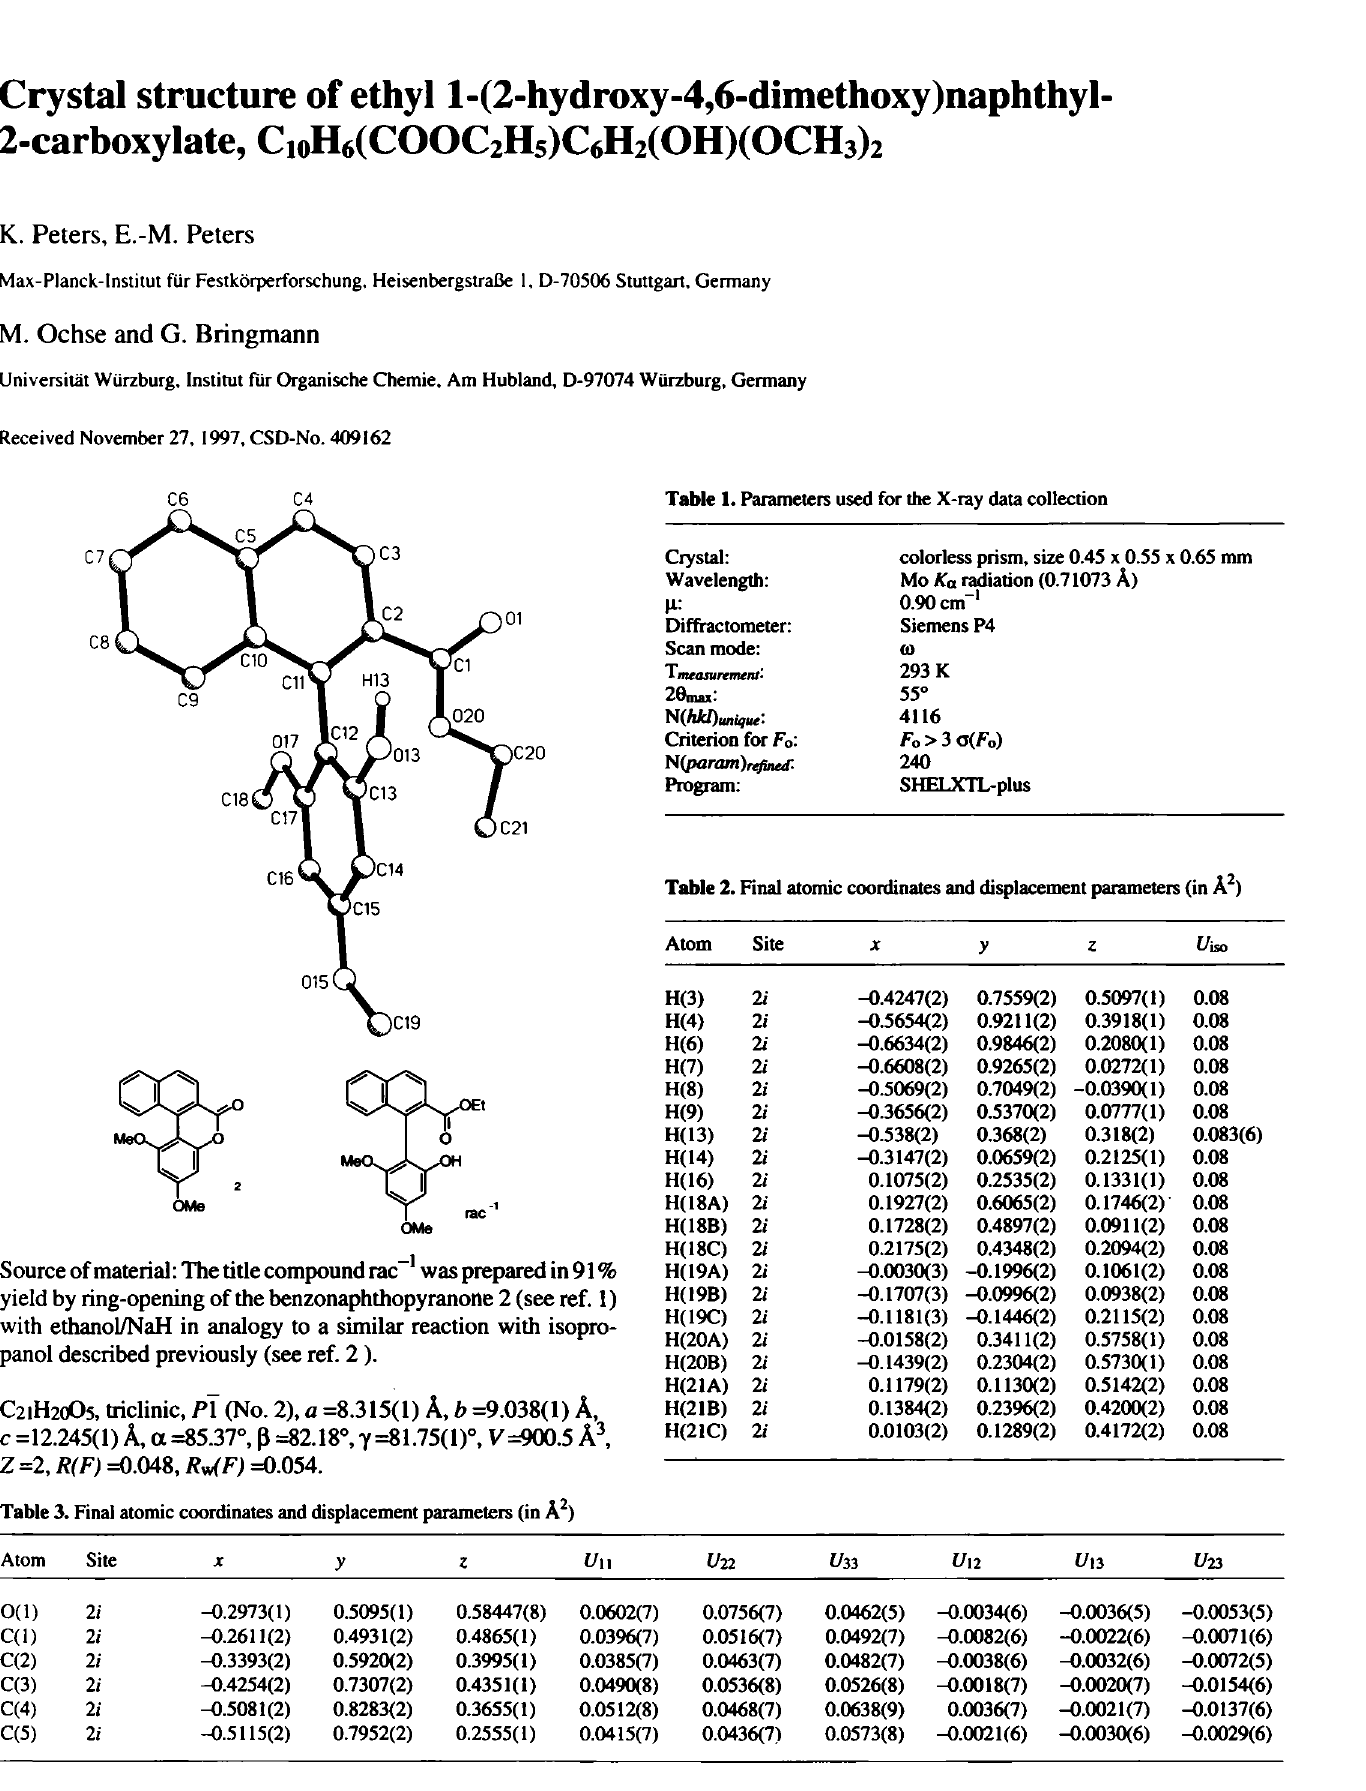
Table 1. Parameters used for the X-ray data collection